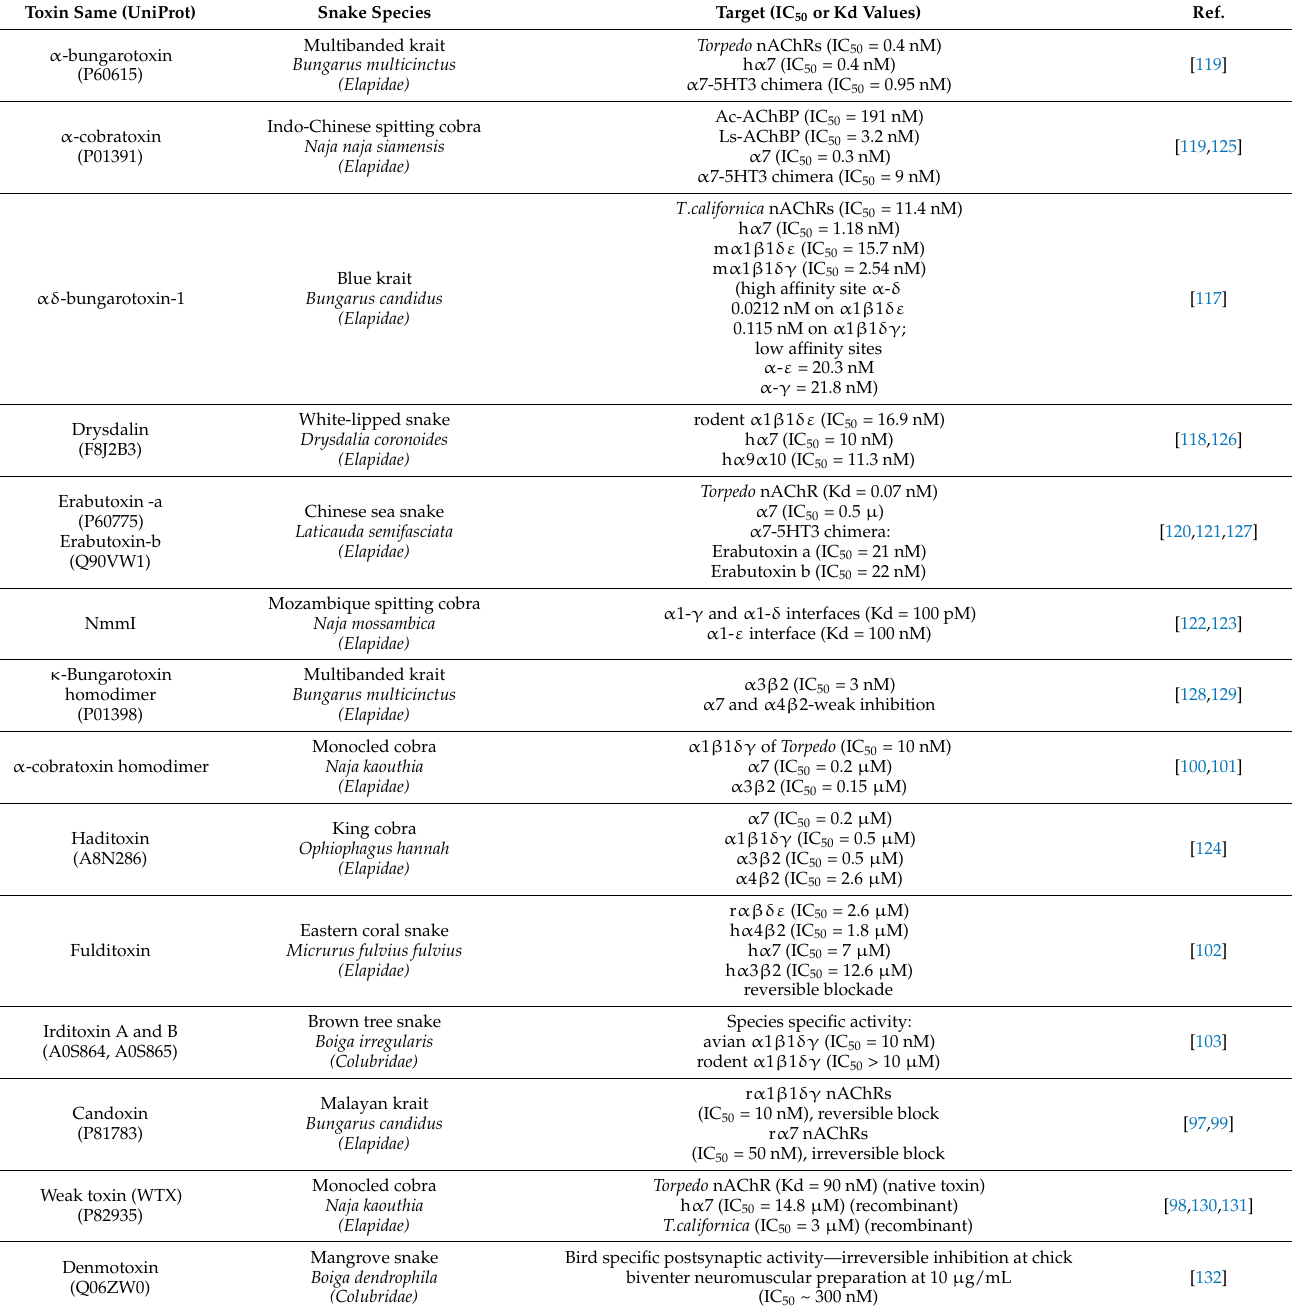
Table 2. Toxins of snake origin targeting nAChRs.